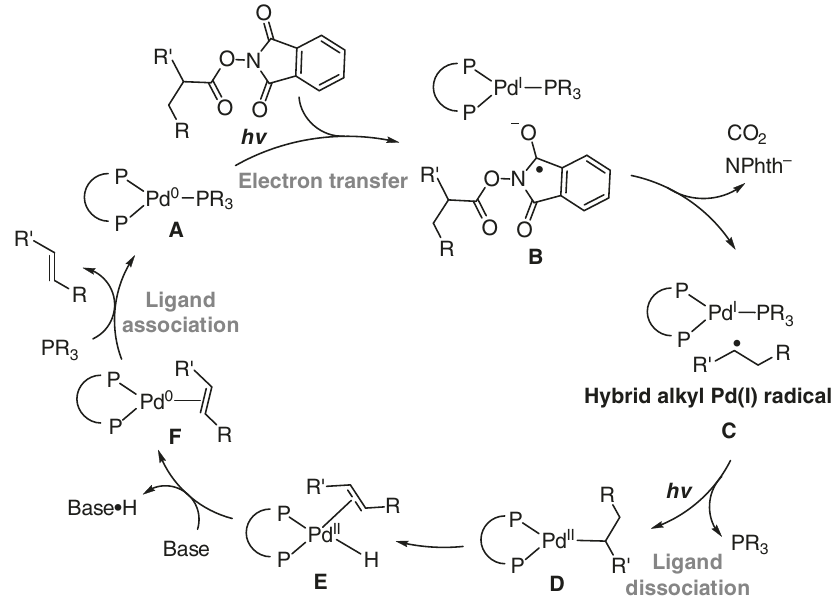
Fig. 8 Proposed mechanism. Mechanistic insights regarding to irradiation effect and dual ligand